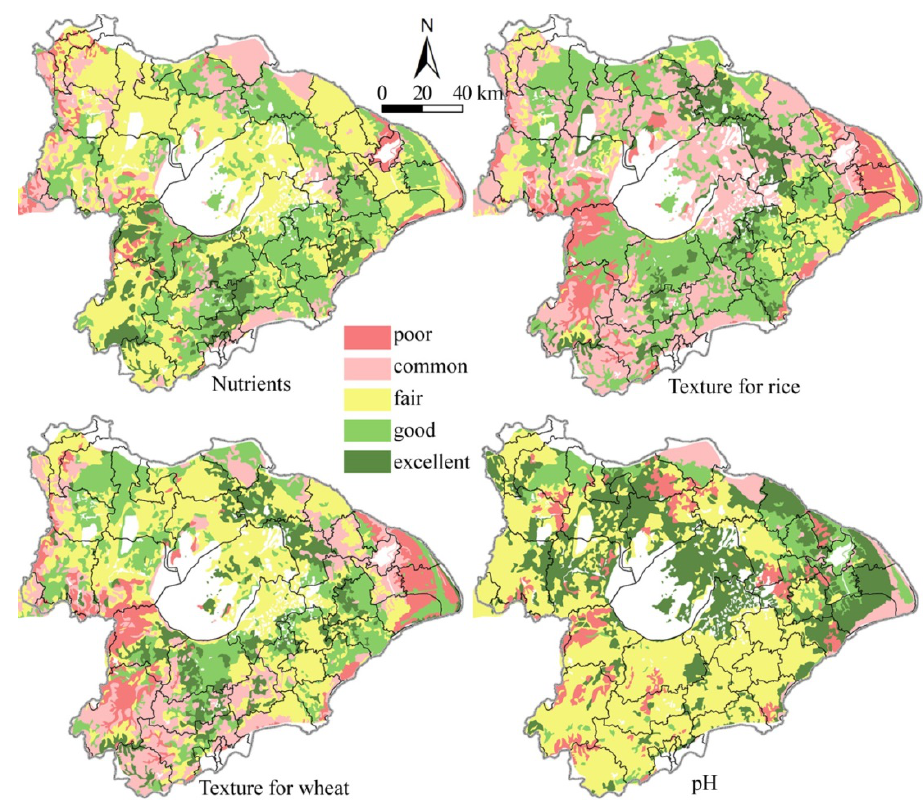
Figure 3. Soil fertility classification patterns.